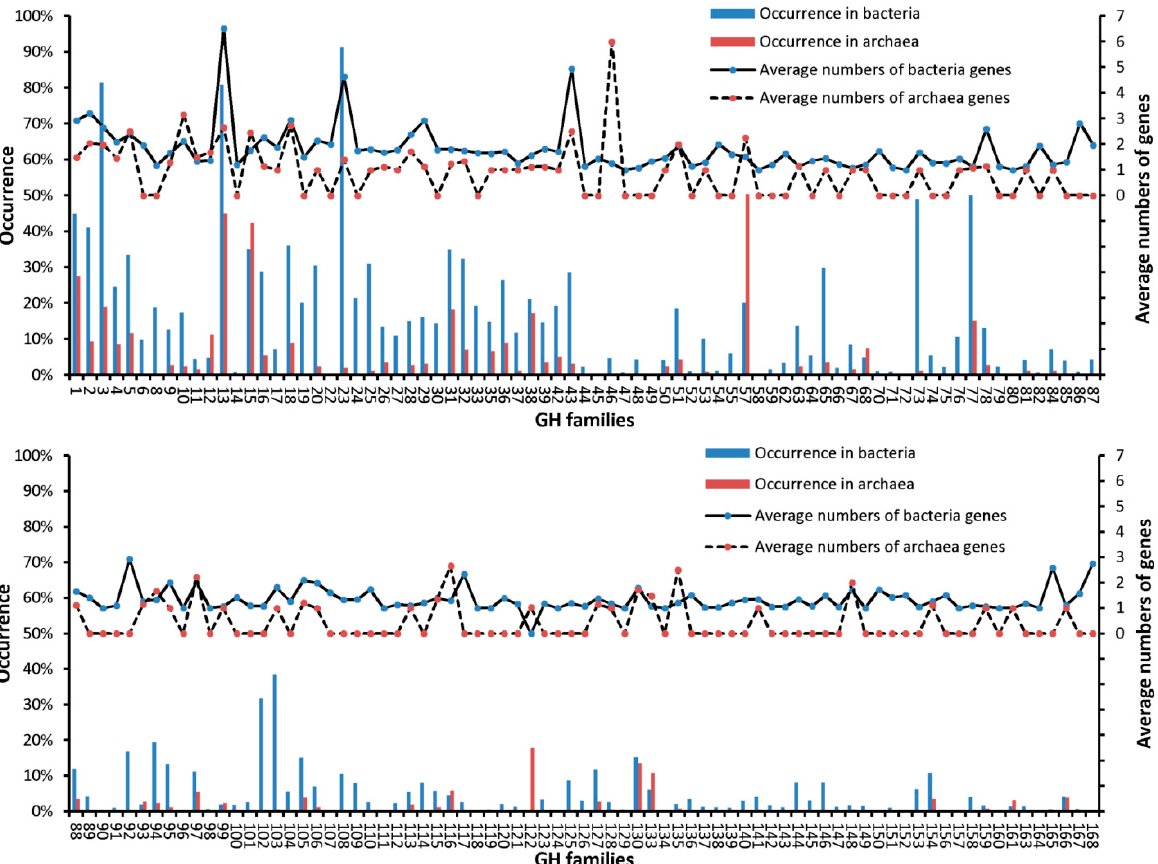
Figure 1. Occurrence frequencies and average numbers of genes for various glycoside hydrolase families (GHFs) in prokaryotes. The calculations were based on the aveF matrix, and rare GHFs for the prokaryotes are not shown. Average number of GH genes was calculated according to the total number of genes in a specific GHF divided by the count of species which possess at least one gene for this GHF.